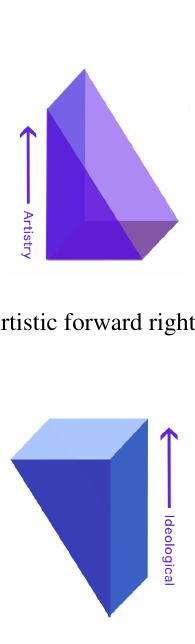
Fig. 2 Ideological reverse right triangle.